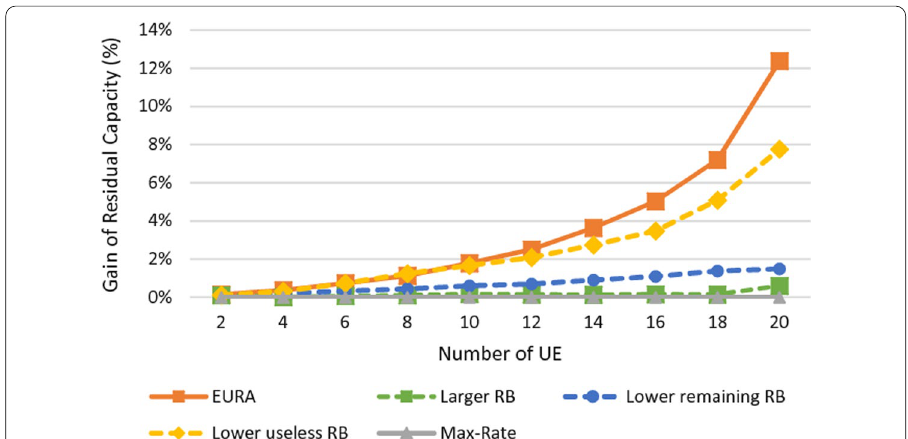
Fig. 16 Gain of residual capacity between EURA with three mechanisms and Max Rate; The performance gain of residual capacity between EURA with three mechanisms and Max Rate